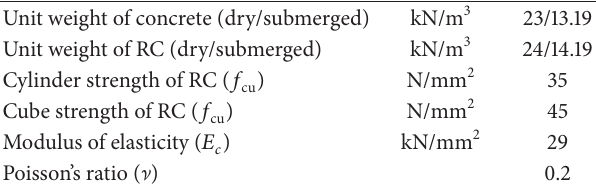
Table 1: Material properties of